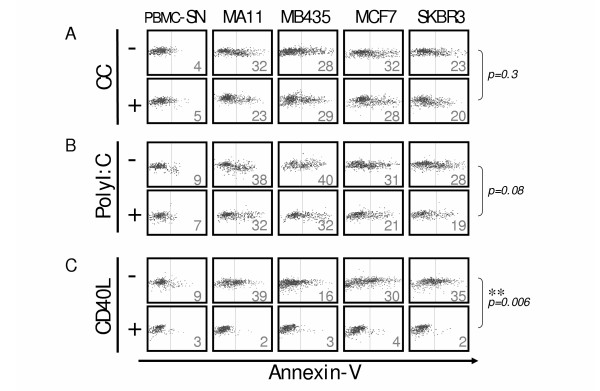
CD40 stimulation protects blood dendritic cells (DCs) against tumor-derived supernatant (TDSN)-induced apoptosis. TDSN-induced apoptosis in blood DCs was determined by Annexin-V binding following incubation (24 h) in the presence or absence of: (a)a combination of inflammatory cytokines (tumor necrosis factor-α, IL-1β, IL-6 and prostaglanding (PG)E2 as a cytokine cocktail (CC)); (b)synthetic double-stranded RNA (poly I:C); or (c)CD40 ligand (CD40L) prior to culture (24 h) with 50% (v/v) peripheral blood mononuclear cell-conditioned supernatant (PBMC-SN) or TDSN (MA11, MB435, MCF7 and SKBR3). Representative dot plots (SSC on y-axis versus apoptosis on x-axis) are shown with numbers indicating the percentage of apoptotic cells. Five independent experiments were performed for which p-values are indicated.